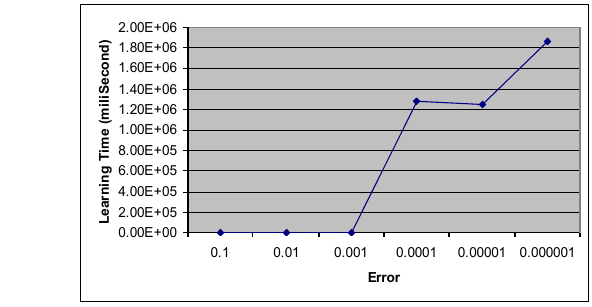
Figure 8. Learning times of the desired errors (a) for quant = 4 and  = 0.6 (b) for quant = 4 and  = 0.4.